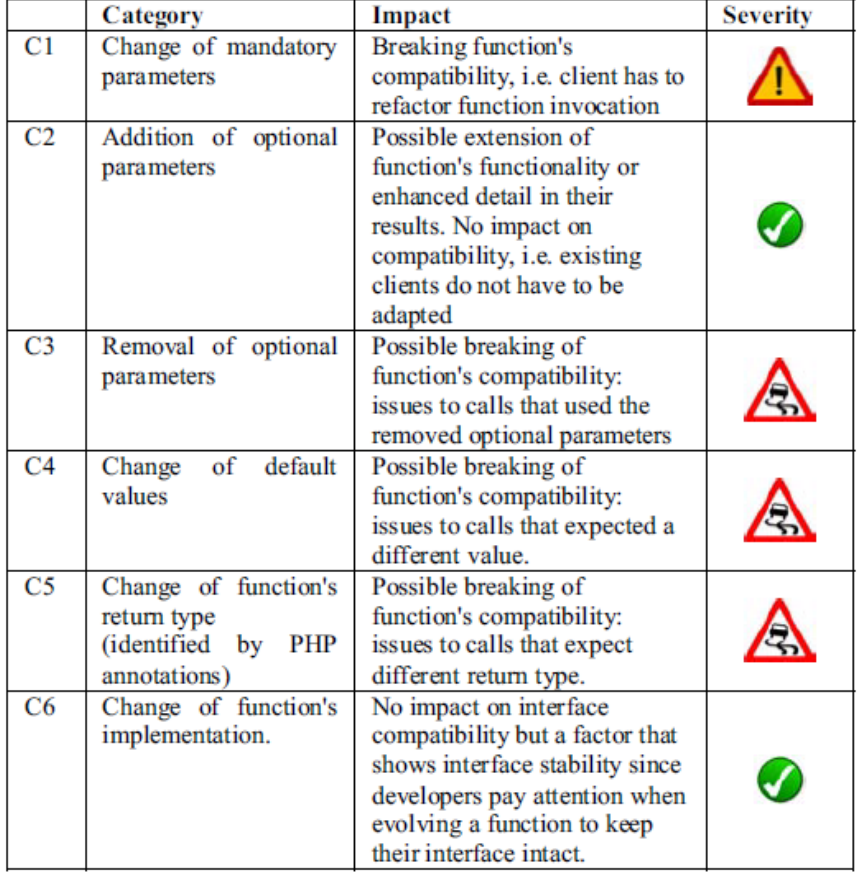
Fig. 2. Change cases of function signatures